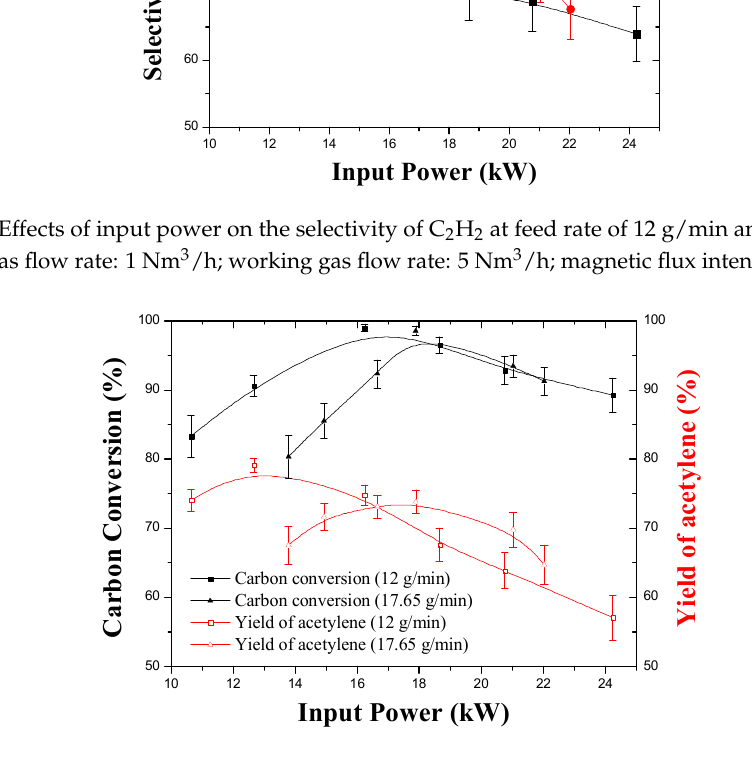
Figure 5. Effects of input power on the carbon conversion and yield of C 2 H 2 at feed rate of 12 g/min and 17.65 g/min (Carrier gas flow rate: 1 Nm 3 /h; working gas flow rate: 5 Nm 3 /h; magnetic flux intensity: 0.077 T).